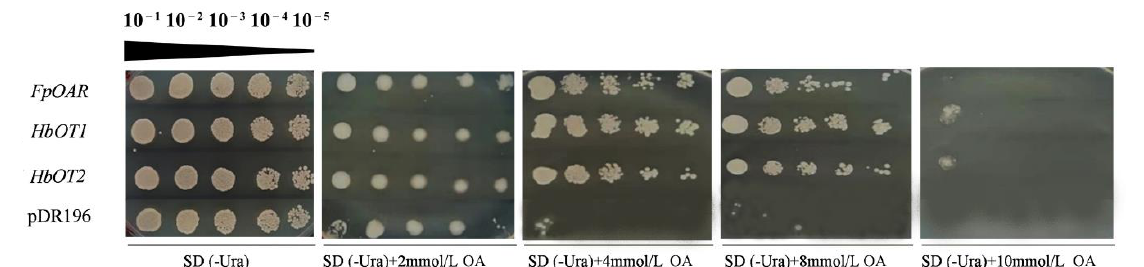
Figure 6. Growth of yeast transformants under different concentration of oxalic acid. The yeast transformants containing pDR196 empty vector and FpOAR were used as the negative control and positive control, respectively. The oxalic acid concentrations used were 0 (CK), 2, 4, 8, and 10 mmol/L according to [34] and our series of experiments. The yeast concentrations for each treatment were 10 − 1 , 10 − 2 , 10 − 3 , 10 − 4 , and 10 − 5 , from left to right. Table 2. The pH variation of culture solution for yeast transformants containing pDR196 empty vector (negative control), FpOAR (positive control), HbOT1 , and HbOT2 under 13 days’ 2 mmol/L oxalic acid stresses.